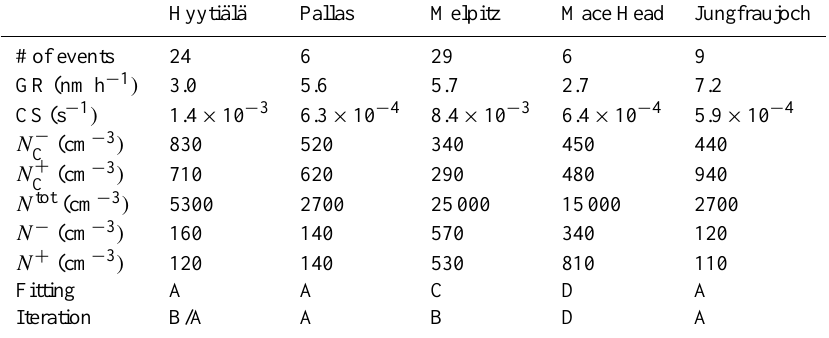
Table 4. The values of growth rate (GR), condensation sink (CS), concentrations of small ions ( N ± charged) and charged nucleation mode particles ( N tot and N ± ) from five measurement sites. The values were used to assess whether or not the iteration and the fitting method would be suitable for data analysis in these particular conditions: A = suitable as such, B = coagulation processes need to be added to the method, C = not suitable due to coagulation processes, D = not suitable due to too small growth rate. If the assessment was different for the negative and positive polarity, both of them are presented in the table (negative/positive polarity).